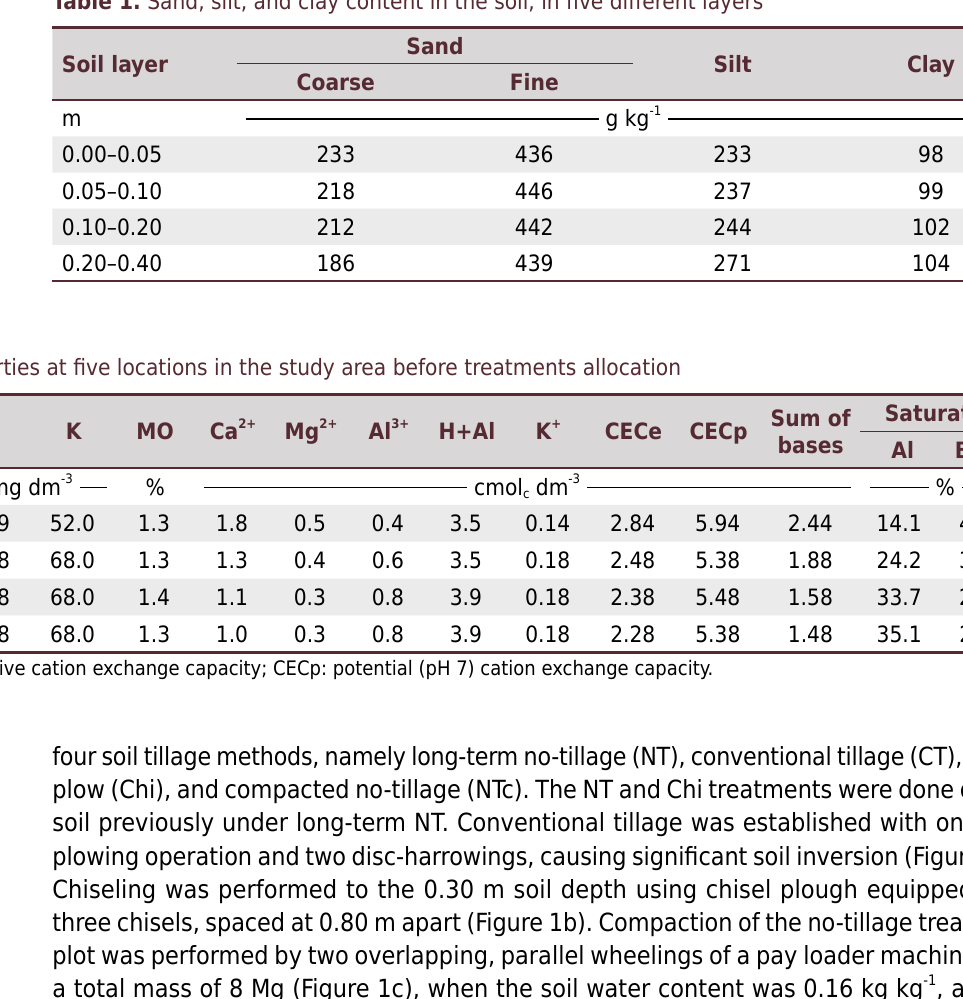
Table 1. Sand, silt, and clay content in the soil, in five different layers Sand Soil layer Coarse Fine